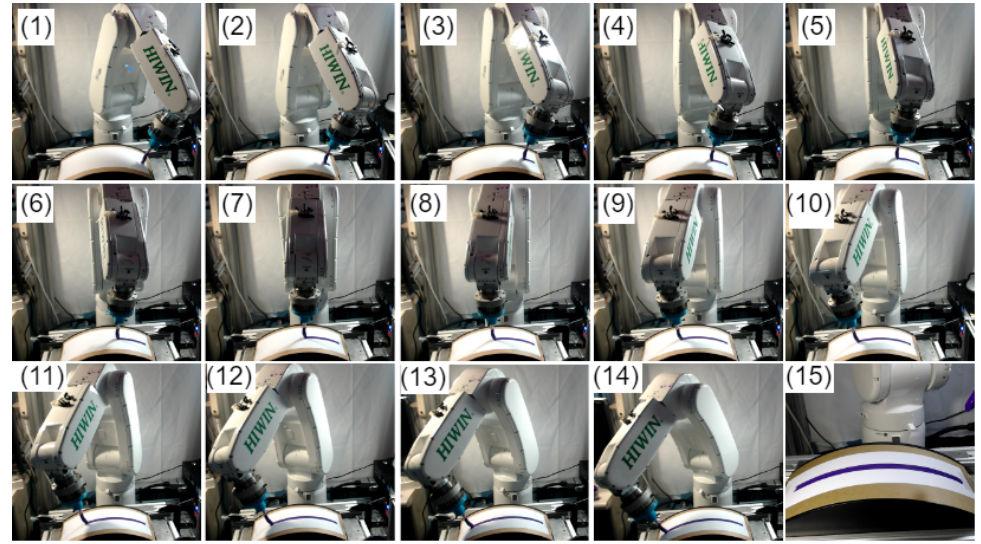
Figure 13. Robot painting a paper employing the obtained normal trajectory: ( 1 – 14 ) Display the robot while using the normal trajectory to paint the curved surface, while ( 15 ) depicts the completed painted trajectory.